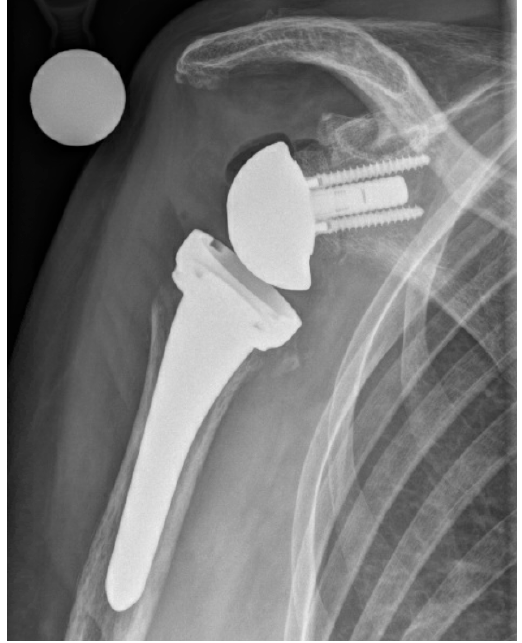
Figure 2. Postoperative anterior–posterior X-ray imaging of a right shoulder after prosthesis reimplantation of a reverse shoulder arthroplasty (uncemented standard stem) and glenoidal augmentation with human allograft due to glenoid erosion.